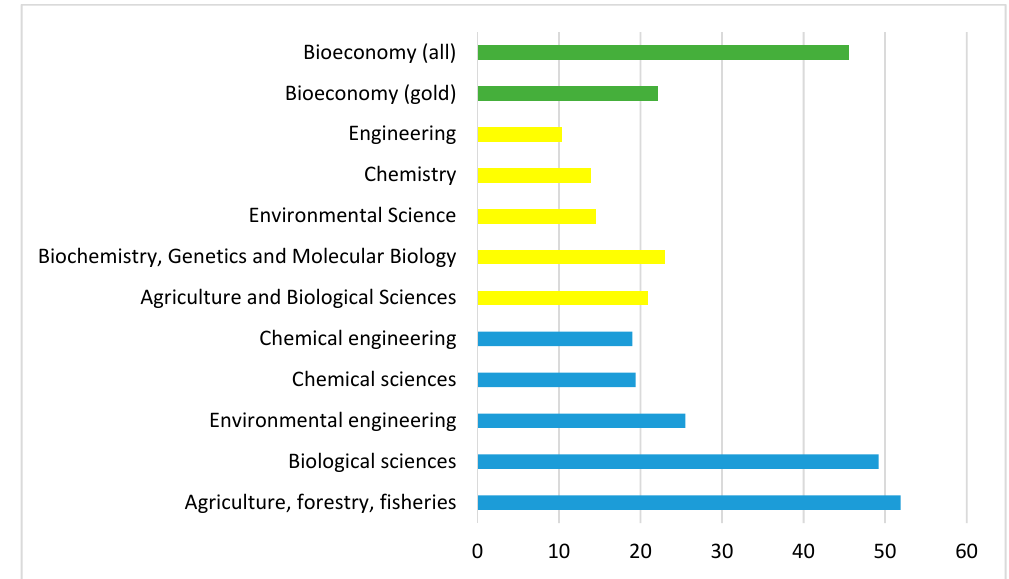
Figure 12. Percentage of OA articles (explication in text).